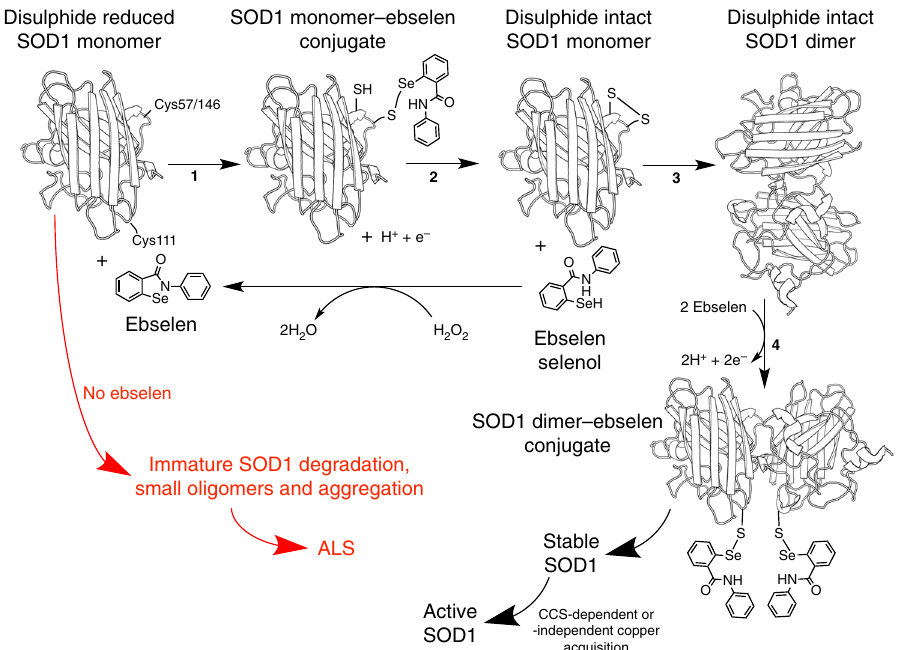
Fig. 6 Mechanism of SOD1 stabilization by ebselen. In the absence of ebselen, monomeric, disulphide-reduced, metal-free mutant SOD1 is highly likely to remain globally unfolded and be degraded or accumulate as small toxic oligomers or aggregates, which are characteristic of ALS neural tissues (red). However, in reaction 1, ebselen forms a selenylsulphide bond with either Cys57 or Cys146 on newly translated SOD1. 2. Selenol – disulphide exchange forms the SOD1 intra-subunit disulphide bond and frees the ebselen selenol. Reduction of hydrogen peroxide by ebselen selenol reforms the ebselen heterocycle. This recycling process indicates that relatively small amounts of ebselen could promote SOD1 maturation. 3. SOD1 disulphide formation promotes correct folding, zinc binding and dimerization. 4. Further modi fi cation of Cys111 by ebselen prevents monomerization by ALS mutations, thus maintaining stable, active, fully metalated, homodimeric